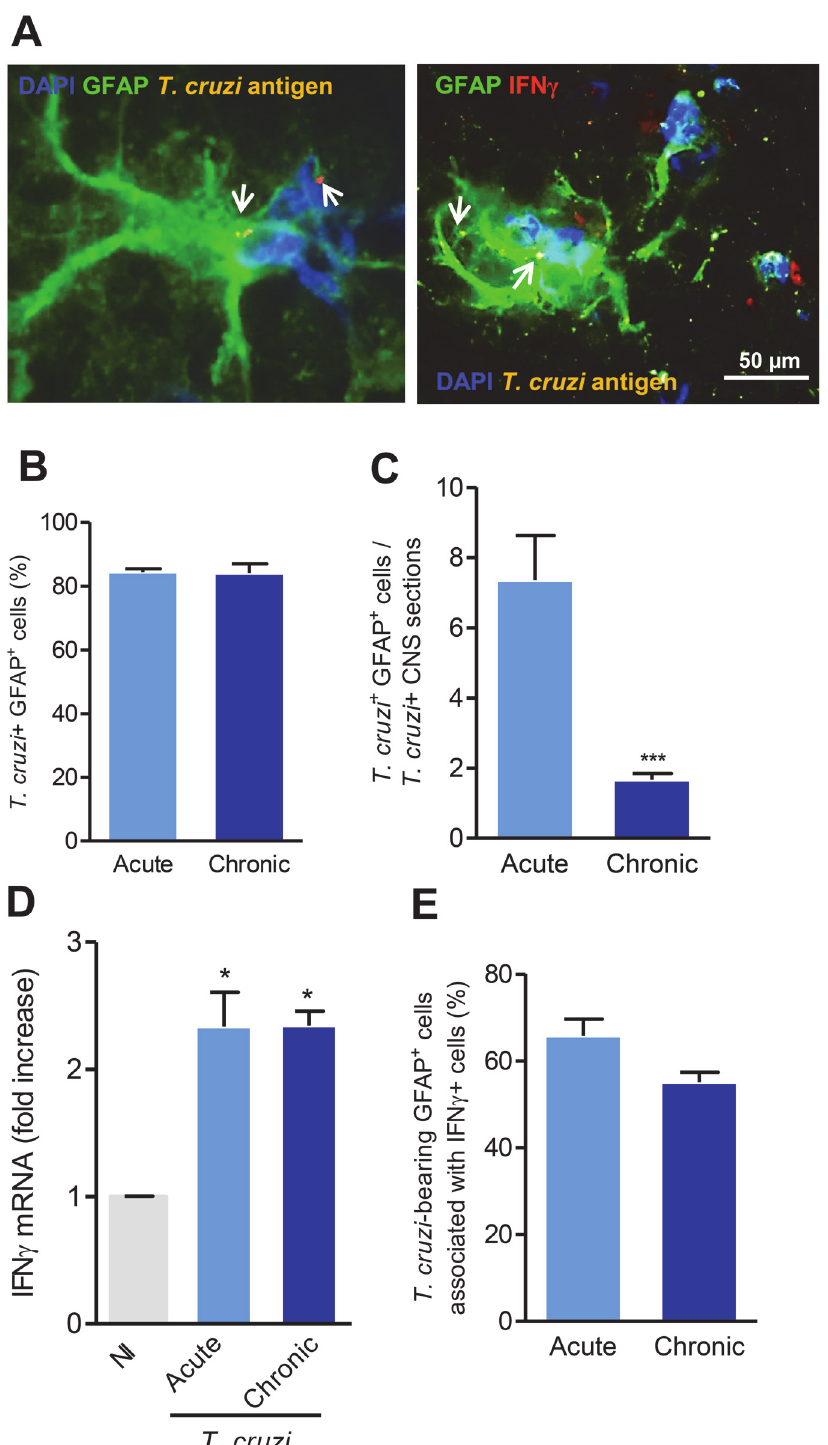
Fig 1. Trypanosoma cruzi antigens are detected in the central nervous system inside astrocytes in the presence of IFN γ . (A) Immunohistochemical staining of CNS sections of acutely (42 dpi) T. cruzi -infected mice showing parasite antigens-bearing astrocytes (left panel) and parasite antigens-bearing astrocyte surrounded by IFN γ -expressing cells (right panel). Arrows indicate parasite antigens detected by immunohistochemical staining using polyclonal anti- T. cruzi antibody. (B) Frequency of T. cruzi antigens +